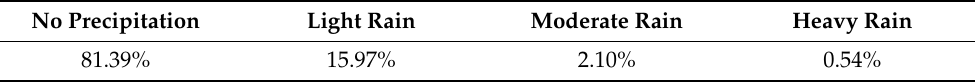
Table 3. Percentage of different precipitation intervals (this proportion is taken from IMERG precipi-